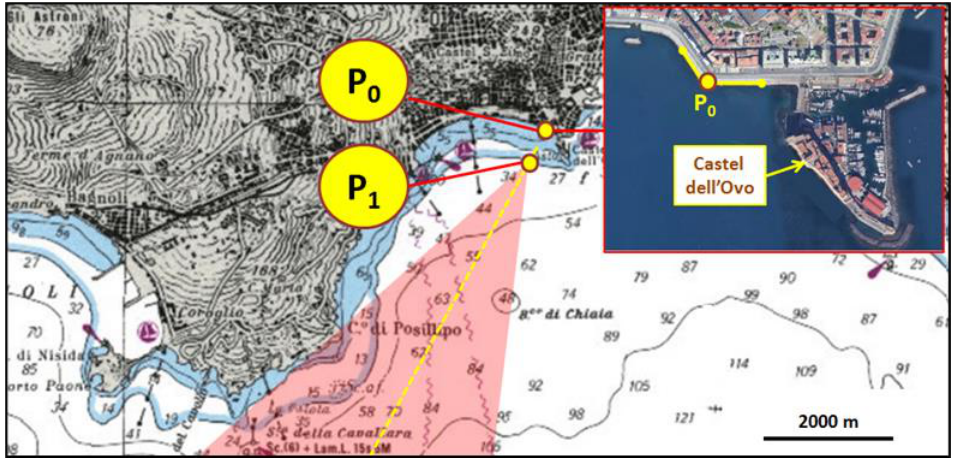
Figure 10. Position of the point P 0 (coastal waterfront point) and P 1 (offshore point, with seafloor at −34 m), significant in analysis of wave motion. Base map by Reference [47].